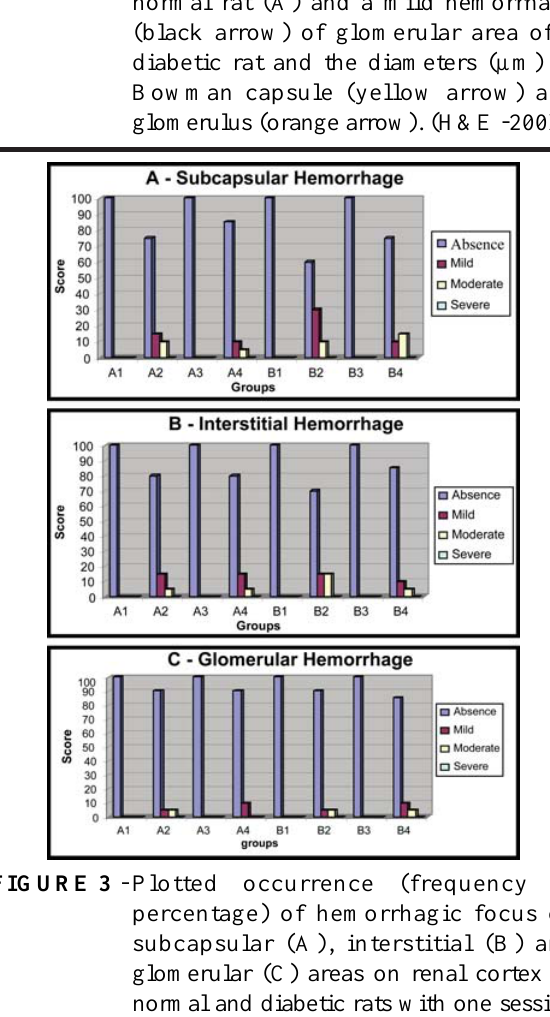
FIGURE 3 - Plotted occurrence (frequency in percentage) of hemorrhagic focus on subcapsular (A), interstitial (B) and glomerular (C) areas on renal cortex of normal and diabetic rats with one session ESW (A4 / B4) or repeated ESW (A2 /